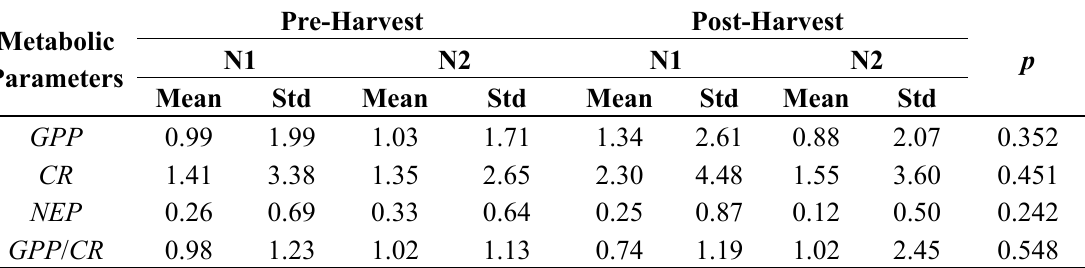
Table 1. Means and standard deviations of gross primary productivity ( GPP ,